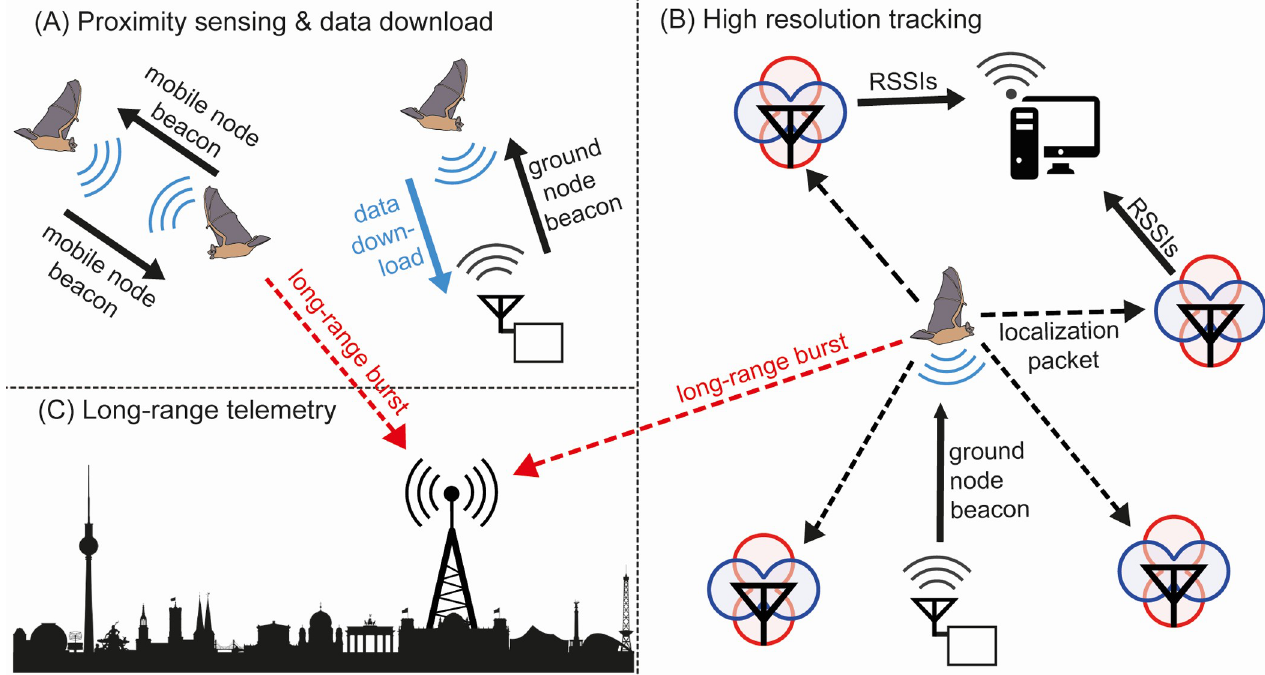
Fig 1. Wireless biologging system overview. (A) Animal-borne mobile nodes document animal-animal meetings, which are triggered by mobile-node beacons 24/7 and independently of the ground infrastructure. Each mobile node forwards its meeting data when it receives beacons from a ground node that is dedicated to downloading and storing data. (B) When a tagged animal enters a grid of localization nodes (depicted by an antenna with red/blue gain patterns), a beacon of a tracking-dedicated ground node triggers the transmission of localization packets from the mobile node to the localization nodes. RSSIs of the impinging localization packets are then sent from the localization nodes to a work station via a WLAN. (C) Long-range bursts, which contain encoded sensor data, are received by long-range receivers. Long-range telemetry enables data transmission over distances of several kilometers at a low data rate. RSSI, received signal strength indicator; WLAN, wireless local area